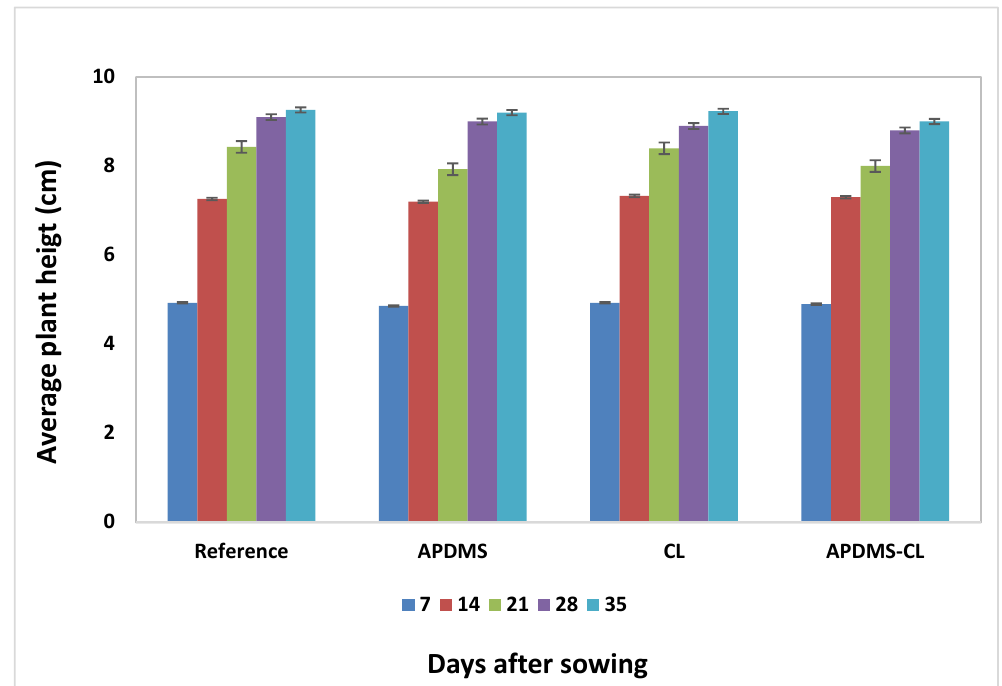
Figure 8 . Average height of tomato plants during the experiment . Figure 8. Average height of tomato plants during the